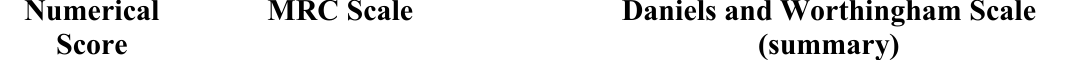
Table 2 : Two manual muscle testing scales – the MRC scale (Guarantors of Brain , 2000) and the Daniels and Worthingham scale (H. J. Hislop & Montgomery,